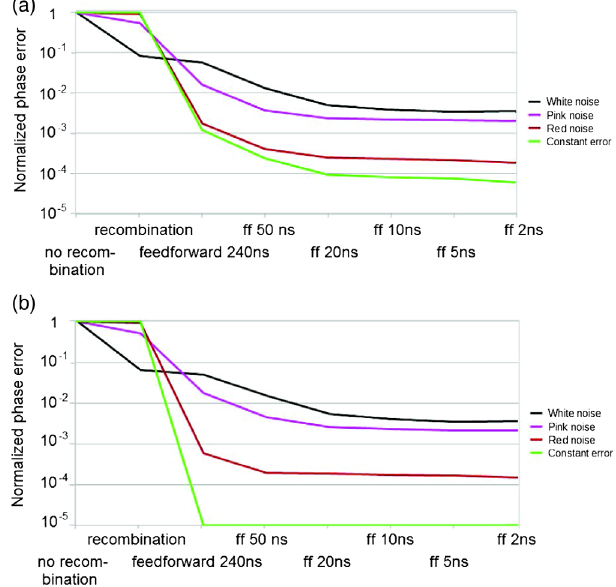
FIG. 20. Normalized phase error of the main beam accelerating rf generated by the errors in drive beam bunch charge (a) and in drive beam accelerating rf phase (b) for different noise spectra. The error value is plotted before recombination (first entry on the x axis), after filtering by the recombination scheme (second entry on the x axis) and after feed-forward correction with different gain durations (following entries on the x axis)